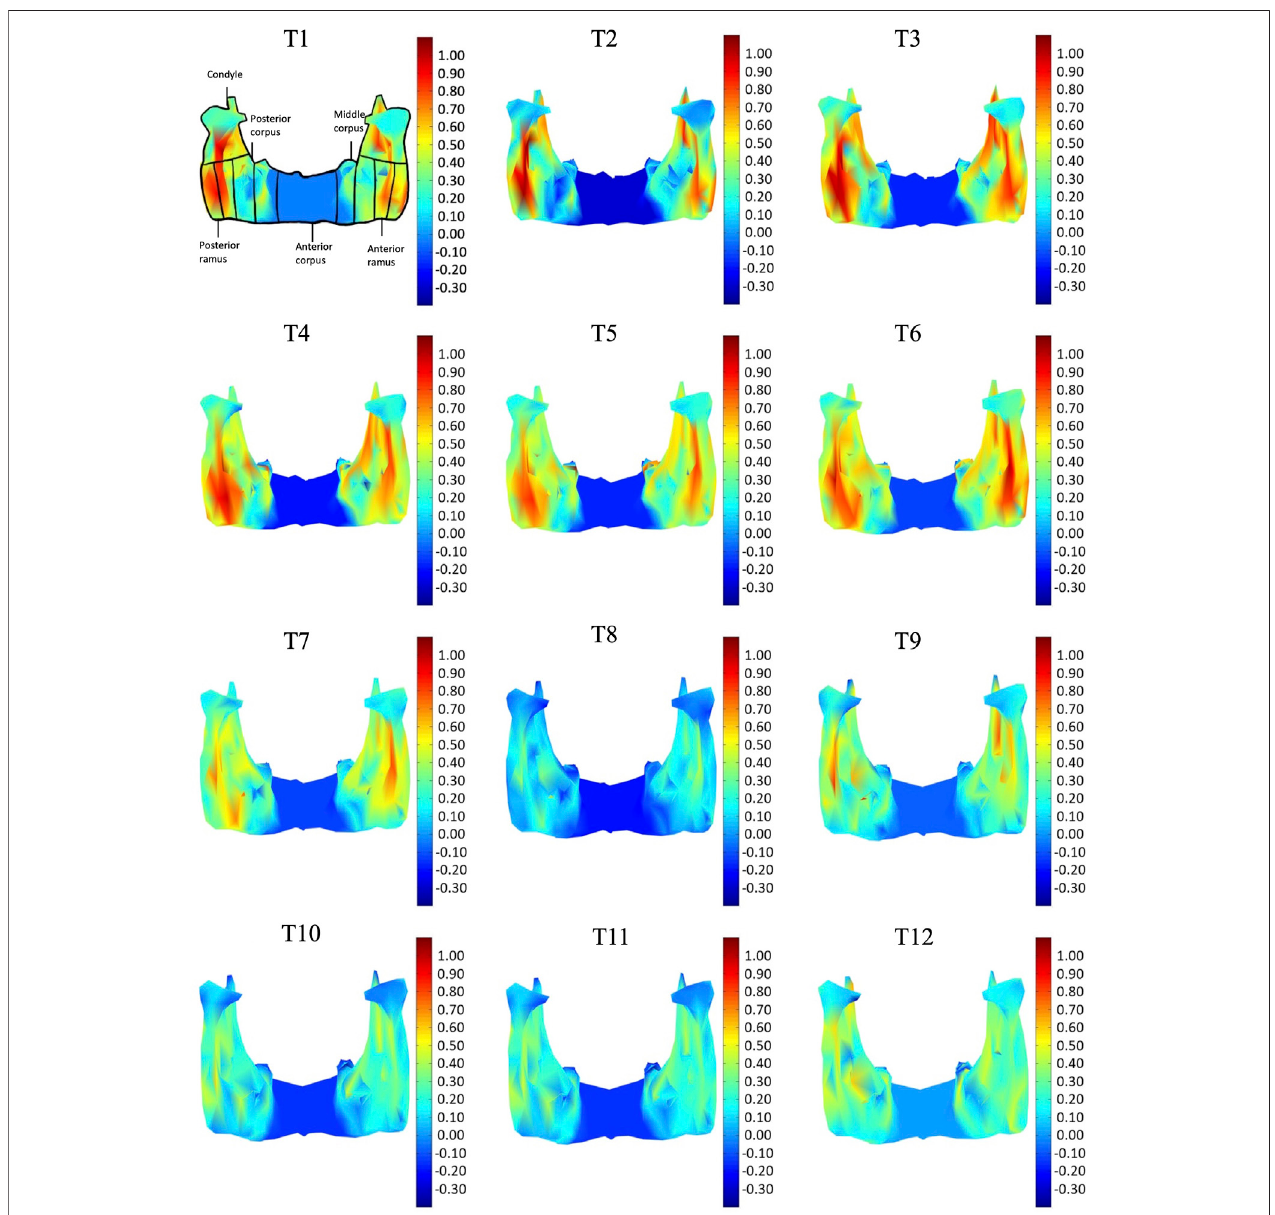
FIGURE 7 | Posterior view of the mandible of a typical subject with monthly rates of morphological changes over the mandibular surface as color maps from T1 to T12. The models were scaled to a similar size for better visualization. (unit: %/month).